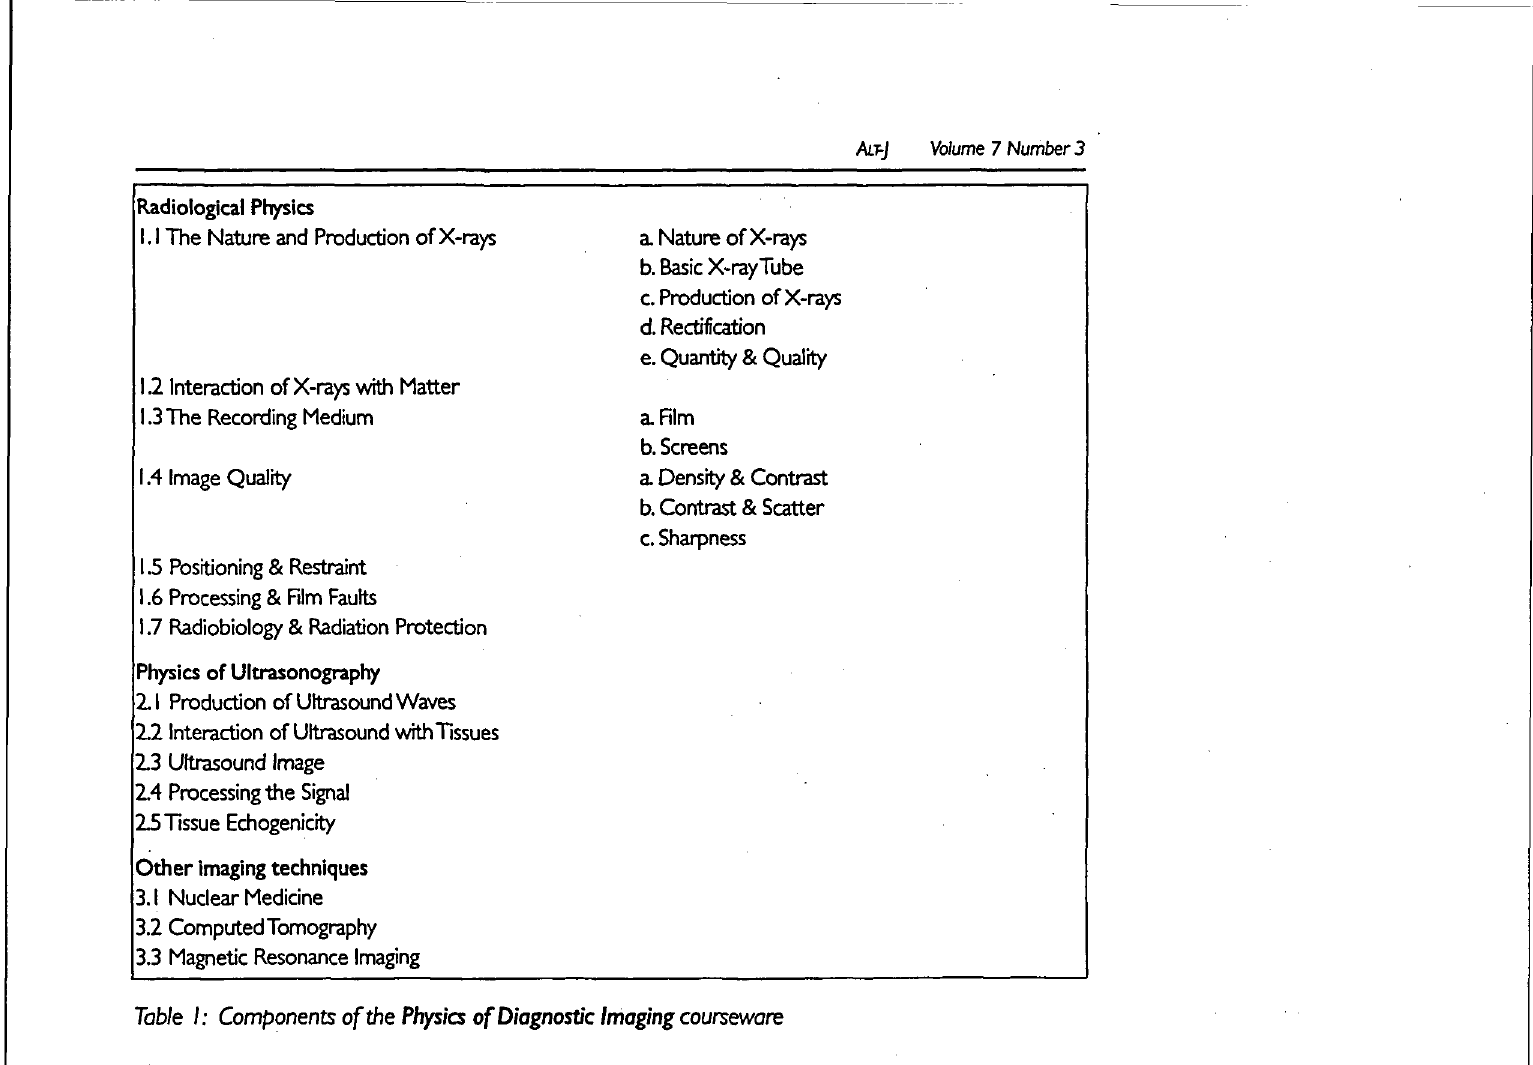
Table I: Components of the Physics of Diagnostic Imaging courseware educational technologists with experience in CAL design and evaluation. The evaluation team noted that the large corpus of information was presented in an engaging and clear way, using a variety of interactions to engage the student, rather than allowing the user to be an entirely passive individual. Like the designers, they stated that the graphic design was extremely clear and easy to view. They did have queries about the appropriateness of some interactions, and suggested putting some pop-up information in separate screens. Other comments related to simplifying instructions and making some changes to animations. In response, a second version of the program was released which incorporated the changes and several other minor improvements. This was released to students in the 1996-7